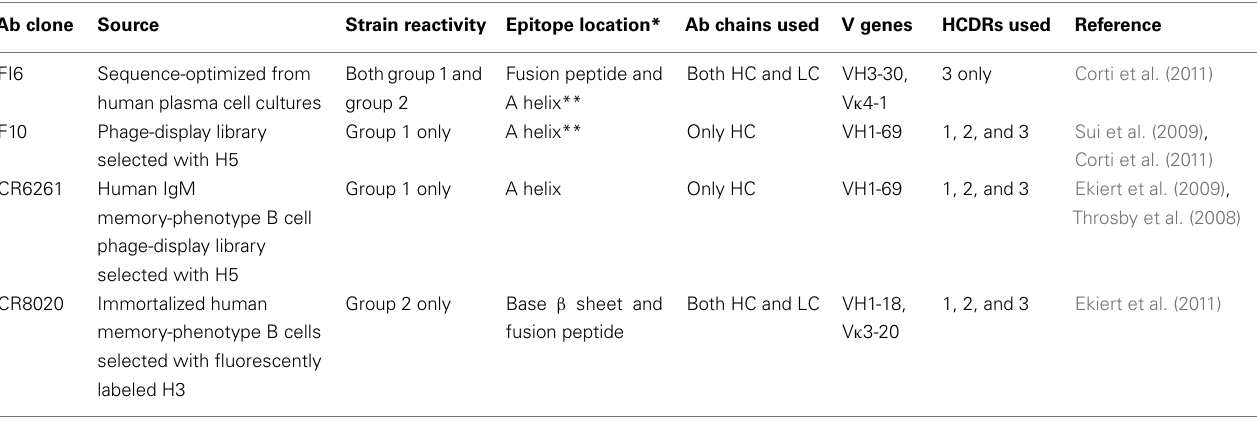
∗ See Figure 1B . ∗∗ FI6 and F10